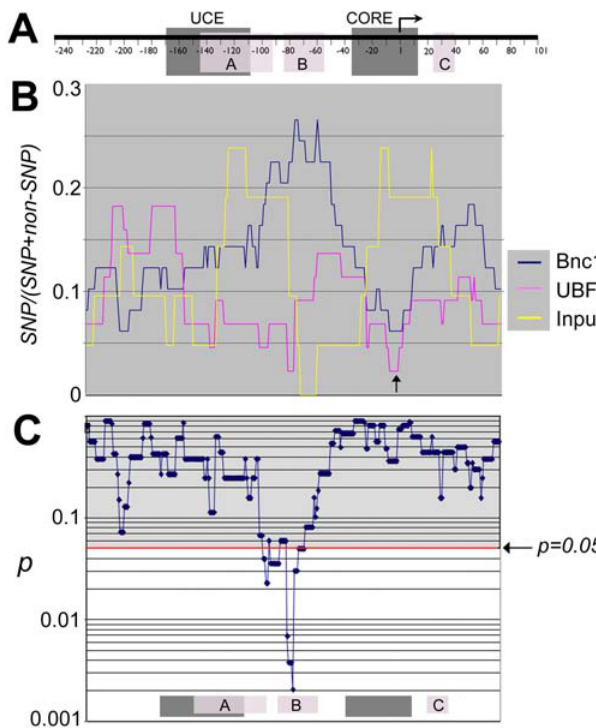
Figure 6. A comparison of the local SNP frequencies in rDNA promoters. A , Depicted is a generic rDNA promoter, to which graphs in B and C are aligned. B , The frequency of SNP was scored by scanning the promoter sequence with a 50-base window. The scores are expressed as the ratio of SNP/(SNP + non-SNP). Each SNP score is aligned to A , using the center nucleotide of each window. Shown are SNP scores of three promoter sets: Bnc1, UBF and the input. An arrow indicates the low SNP frequency near the transcription start site in basonuclin- and UBF-associated promoters, but not in the input. In C, a series of pair-wise chi-square tests were performed on the corresponding SNP frequencies of basonuclin- and UBF-associated promoters. The resulting p values are plotted in alignment with A and B . As a reference, the positions of cis-elements as well as basonuclin binding sites are shown at the bottom of panel B